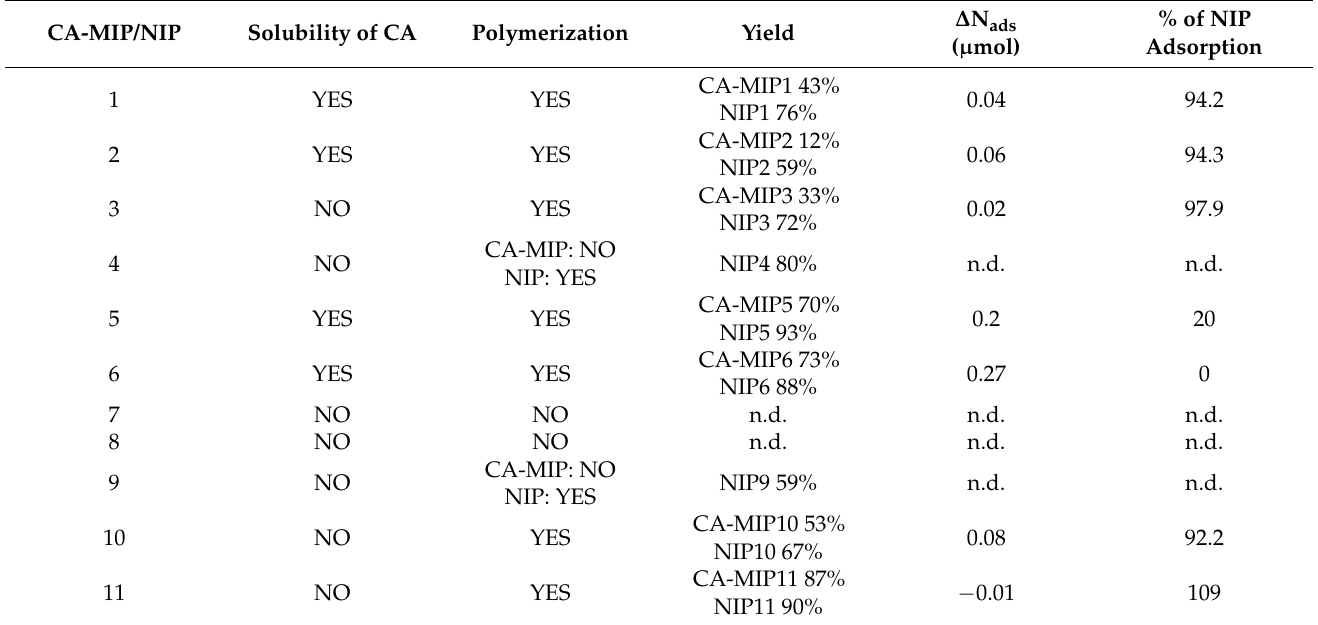
Table 2. Resulting polymers characteristics before and after